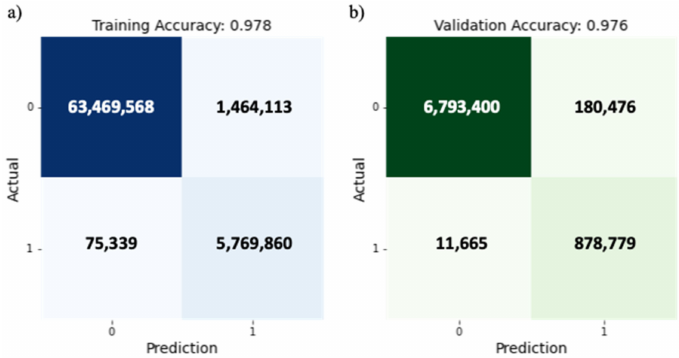
Figure 23. The confusion matrix of ( a ) training data and ( b ) validation data. Table 7. The classification report for the training process on real seismic data. Class Precision Recall F1-score Support non-channel 1.00 0.98 channel 0.80